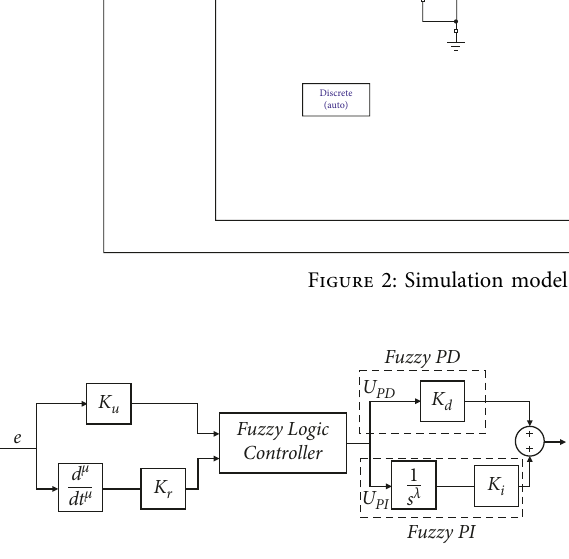
Figure 3: Block diagram of the FOFPID